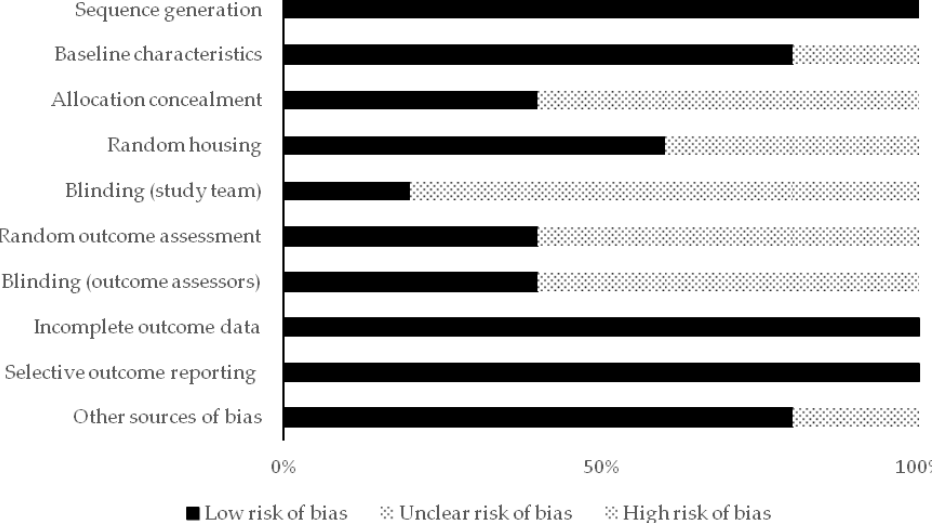
Figure 4. Risk of bias assessment scores in the in vivo studies ( n = 5) with SYRCLE’s tool presented in percentage of articles (% of total).